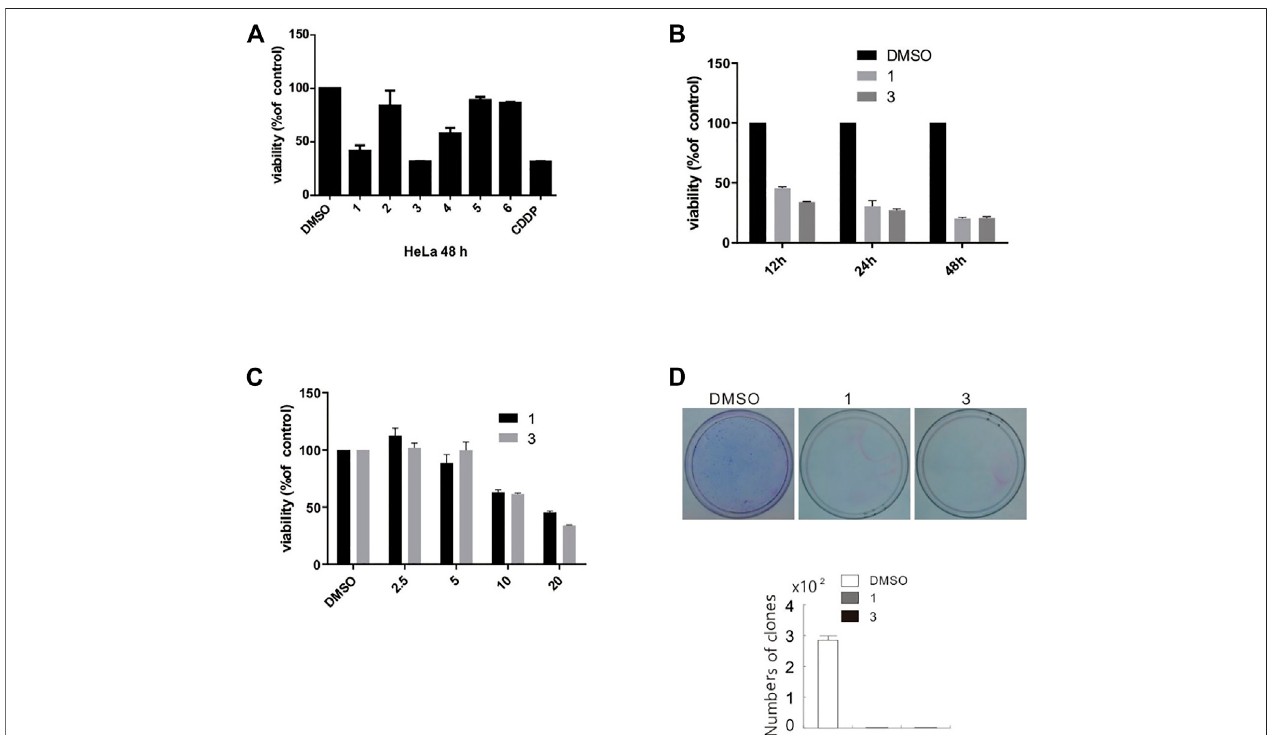
FIGURE 10 | Compounds 1 and 3 markedly inhibited cell viability and proliferation. (A) HeLa cells were challenged with compounds 1 – 6 for 48 h, and detection of cell viability was carried out by MTS assay. (B and C) SW480 cells were treated with compounds 1 and 3 (2.5 – 25 μ M) upon to 48 h, and detection of cell viability was carried out by MTS assay. (D) Colony formation assays in SW480 cells were performed in the presence of compounds 1 and 3 (20 μ M) for 10 days. The image represented quanti fi cation of the signals ( n = 3). For the results of histogram, the data of as mean ± S.D. presented and analyzed by T -test. Similar experiments repeated at least for three times.